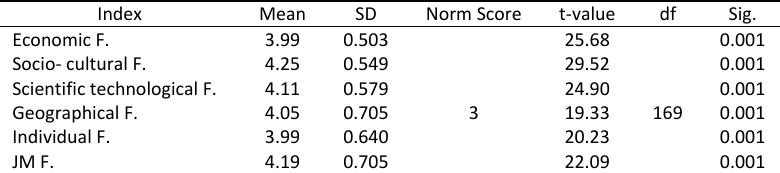
Table 8 : one-sample T-test of research variables